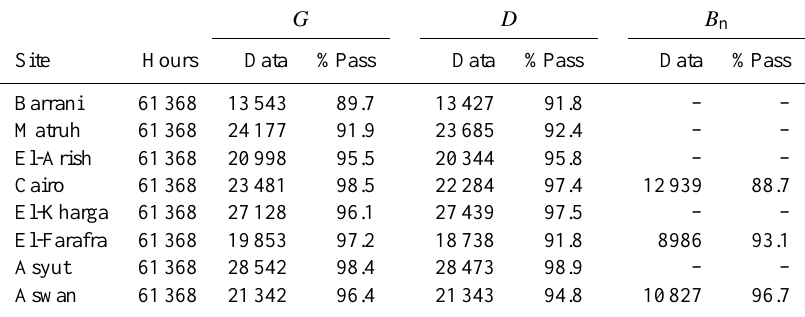
Table 3. Duration of the period 2004–2010 (in hours), numbers of available (non-missing, non-night, non-suspicious) data for G , D and B n . The proportion of available measurements having passed the quality check is also